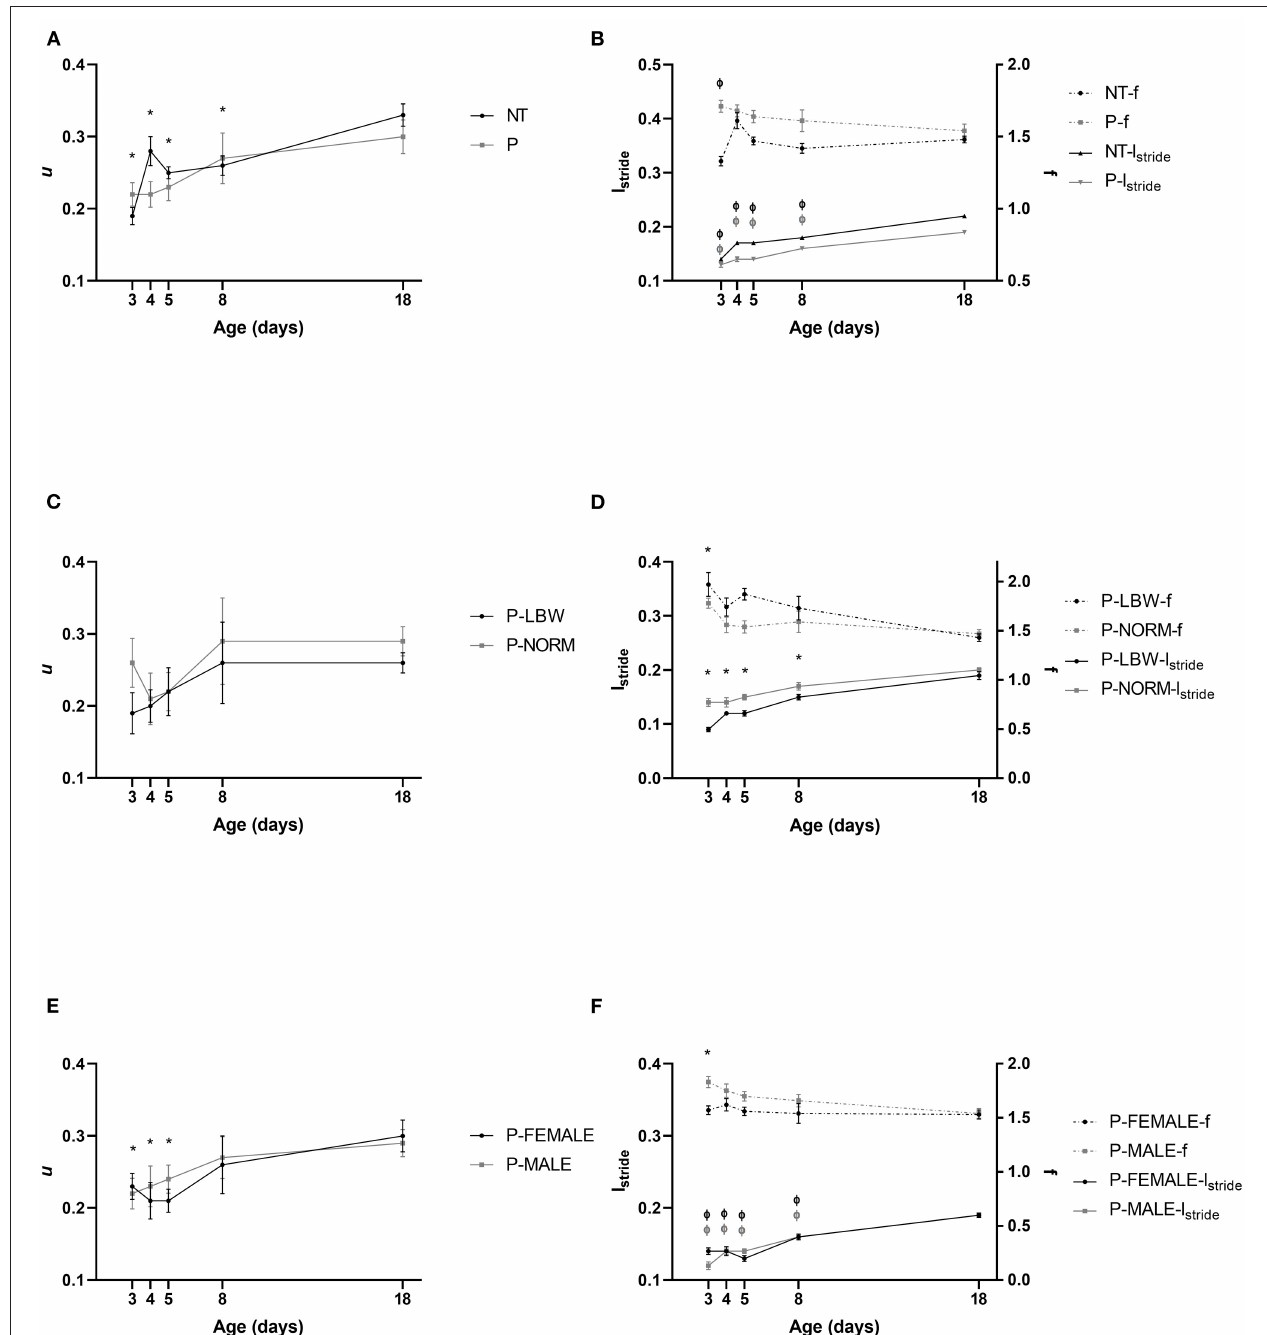
FIGURE 1 | Motor performance. All values are mean SE. (A) Speed ( u , ms − 1 ) according to condition (P: preterm, gray; T: term, black) and age. u of P and T piglets ± is similar. Mean values indicated with * differ from d18. (B) For stride length ( l stride , m, full line) and stride frequency ( f , s − 1 , dotted line), an interaction was observed between condition (P vs. T) and postnatal age. l stride was higher in T than in P pigs. f was lower in T, compared to P pigs at d3, d5, and d8). Mean values of l stride indicated with “ Φ ” differ from d18 for P and T. Except for T piglets increasing their f from d3 to d18, T and P pigs did not change their f with age. (C) Speed ( u , ms − 1 ) of preterm pigs did not differ with birth weight (normal birth weight (P-NORM); low birth weight (P-LBW)) and postnatal age. (D) Stride length ( l stride , m, full line) and stride frequency ( f , s − 1 , dotted line) according to birth weight (P-NORM vs. P-LBW) and postnatal age. P-NORM piglets had a higher l stride and a lower f , compared to P-LBW. Mean values indicated with * differ from d18 for l stride and for f . (E) Speed ( u, ms − 1 ) according to sex of preterm piglets (female: P-FEMALE; male: P-MALE) and age. No differences are noted with sex. Mean values indicated with * differ from d18. (F) Stride length ( l stride , m, full line) and stride frequency ( f , s − 1 , dotted line) according to sex (P-MALE vs. P-FEMALE) and postnatal age. There was an interaction of postnatal age and sex for l stride , indicating that l stride was higher for P-FEMALE at d3 whereas the effect for f was not depending on postnatal age and f was overall higher in P-MALE. Mean values of indicated with “ Φ ” and “*” differ from d18 for l stride and f , respectively. Black colors indicate differences in T while gray colors indicate differences in P piglets.